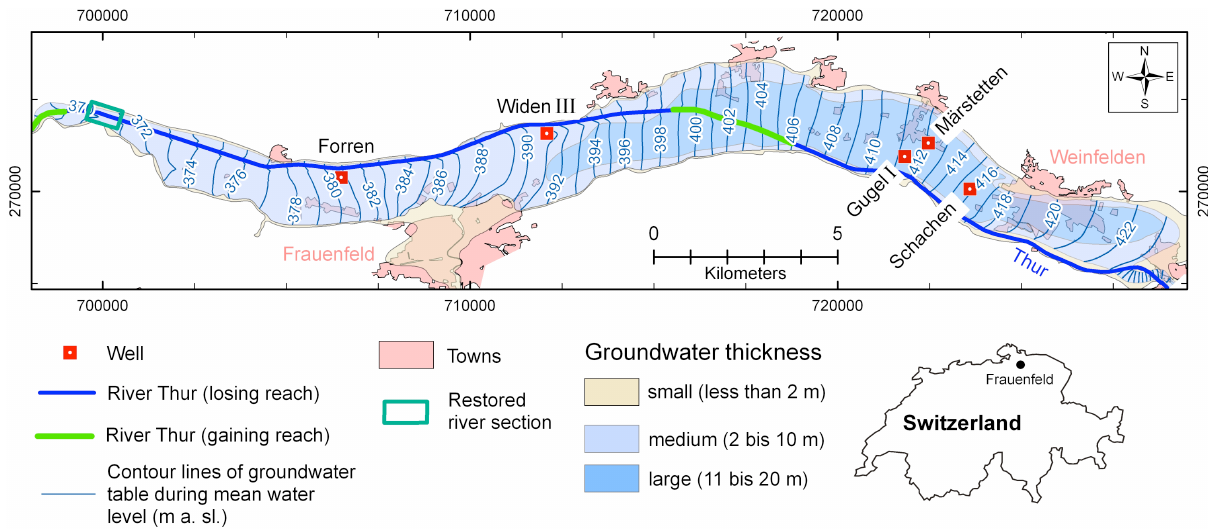
Fig. 1. Map view of groundwater in River Thur valley aquifer, Switzerland. Axes of Swiss Federal Coordinate system. Blue and grey areas, groundwater thickness (dark blue, 11–20m, light blue, 2–10m, grey, < 2m). Pink areas, towns. Green quadrangle, restored river section. Red quadrangles, wells quoted in text. Thick blue lines, River Thur (blue, losing reach, green, gaining reach). Thin blue lines, mean groundwater isopotential lines (ma.s.l.). (Map reproduced with permission of Cantonal Office of Geoinformatics Thurgau, 29 October 2008; modified from Vogt et al.,